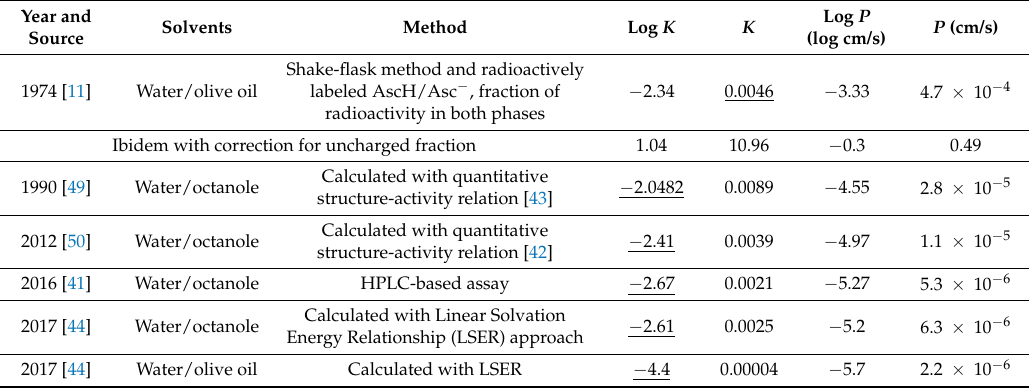
Table 3. Partition coeffcients (log K or K , the respective value is underlined) available in literature. Permeabilites based on these log K or K are estimated with the correlation (see Equations (12) and (13)) of Walter and Gutknecht